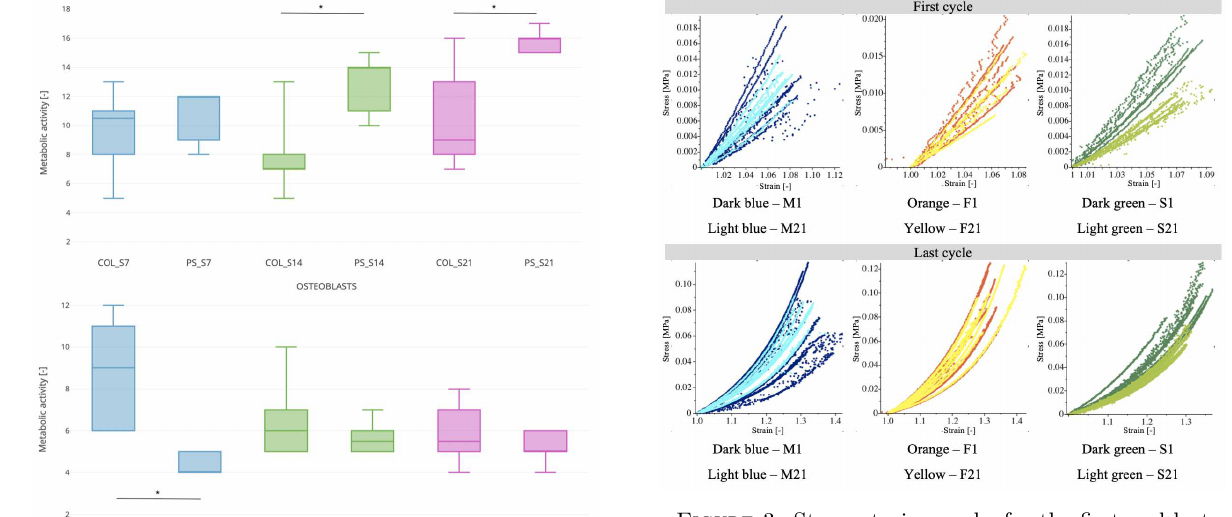
Figure 3. Stress-strain graphs for the first and last load cycles. For specimens exposed in 1. (M1) and 21 (M21), samples with fibroblasts (F1) and day 21 (F21) and samples with osteoblasts (S1) and day 21 (S21).